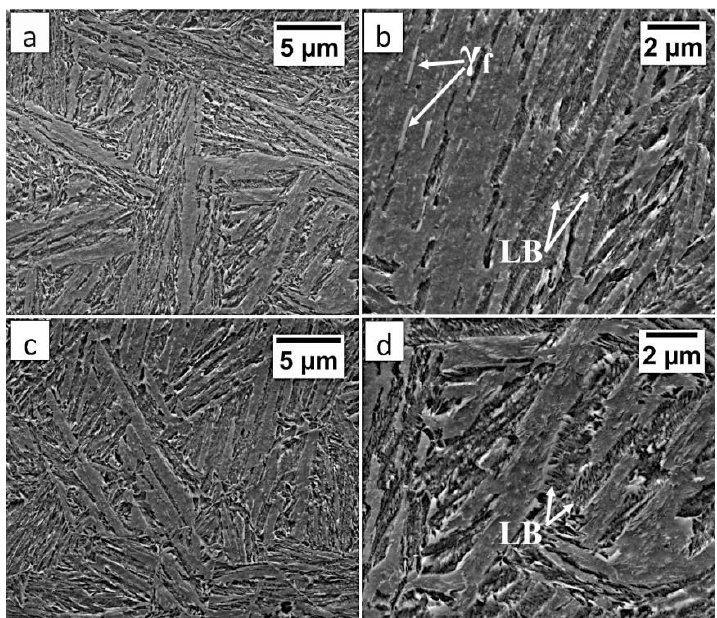
Figure 18. ( a ) The structure of the FZ in the area “A” (marked in Figure 15). Lath morphology of bainite. ( b ) The structure of the FZ in the area “A” (marked in Figure 16). Bainitic ferrite laths and filmy austenite (γ f ), and lower bainite (LB). ( c ) The structure of the HAZ in the area “B” (marked in Figure 16). Lath morphology of bainite. ( d ) The structure of the HAZ in the area “B” (marked in Figure 16). Degenerated upper bainite and lower bainite (LB). Etched by nital, SEM.